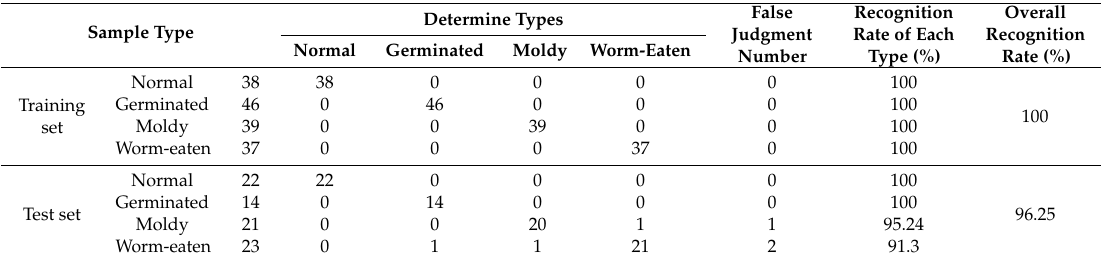
Table 5. The result of the decision fusion model using the DS wheat classification